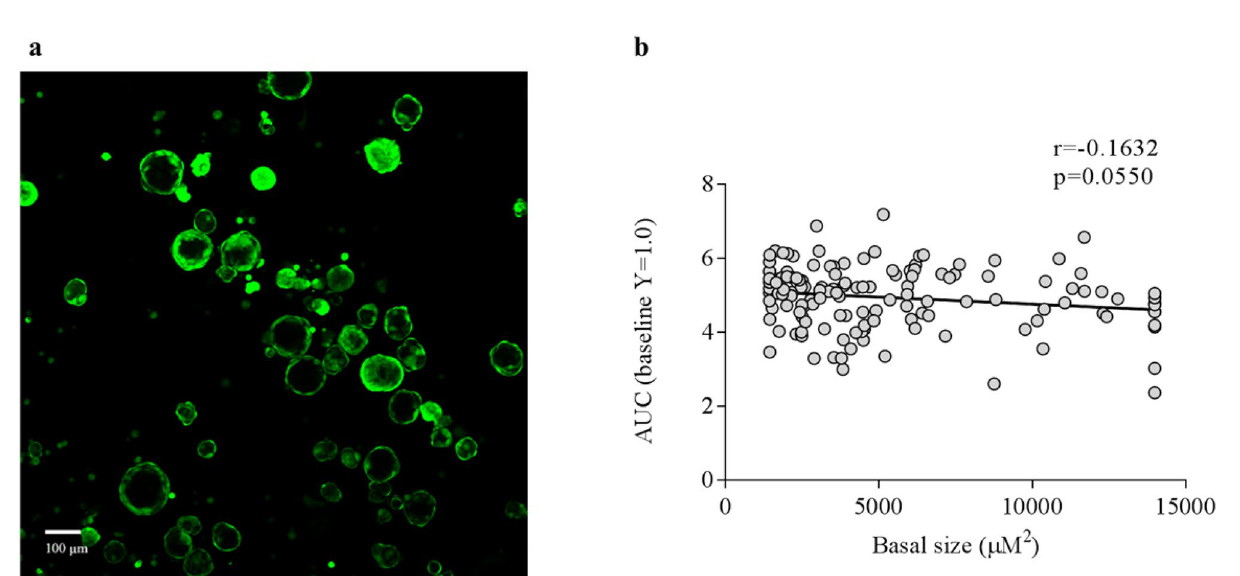
Figure 3. No correlation between basal size of nasospheroids and degree of response after 60 min of FSK incubation. ( a ) Nasospheroids showed diversity basal sizes. ( b ) After excluding non- responders nasospheroids (FR > 1 at t = 60), we matched basal size with AUC values (after CRA analysis). After 60 min of FSK activation in WT nasospheroids, we observed no correlation between the two parameters (basal size and FSK response). Similar results were observed after analysing FR (r = − 0.1216, p = 0.1537) and slopes (results showing slopes of the same experiments are available in Supplementary Information). Results were a combination from spheres grown in conditions 1 and 2. Image taken with confocal microscope LSM780 Zeiss, scale bar created with ImageJ/FIJI 31 and graphic created with GraphPad Prism version 6 33